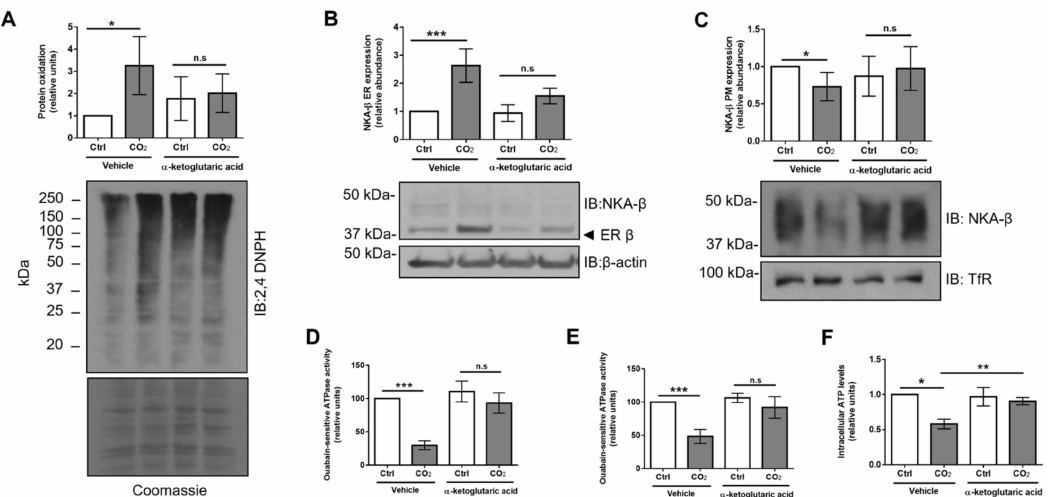
Figure7. Treatmentwith α -KGreverseshypercapnia-inducedproteinoxidationanddecreasesER-retained forms of Na,K-ATPase. ( A ) A549 cells were exposed to 40 (Ctrl) or 120 mmHg CO 2 (CO 2 ) with an extracellular pH = 7.4 for 12 h in the presence or absence of α -KG (10 mM) or vehicle. The ER fraction was isolated by ultracentrifugation and the level of protein oxidation was assessed as described above. Bars represent 2,4-DNPH / Coomassie ratio. Values are expressed as mean ± SD ( n = 3, * p < 0.05, n.s—non-significant). ( B ) A549 cells were exposed to 40 (Ctrl) or 120 mmHg CO 2 (CO 2 ) with